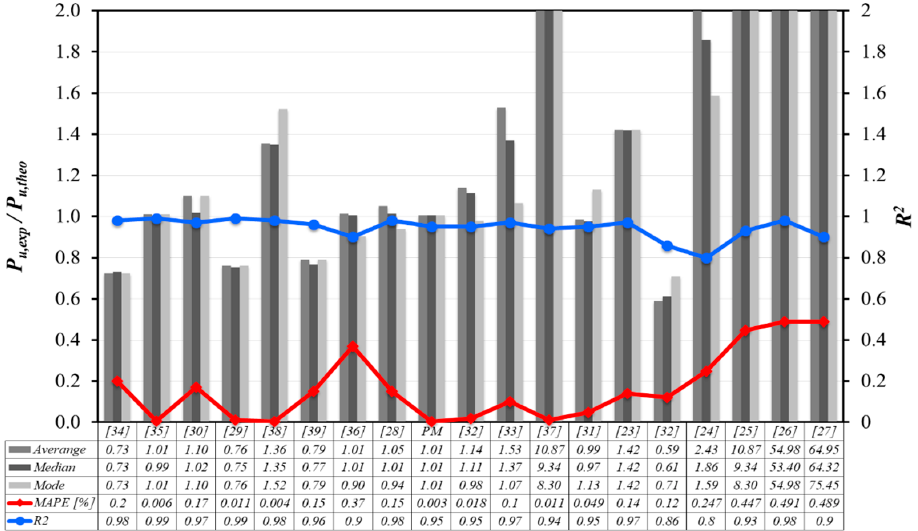
Figure 15. Comparison of the performance of the analytical models with respect the proposed one.